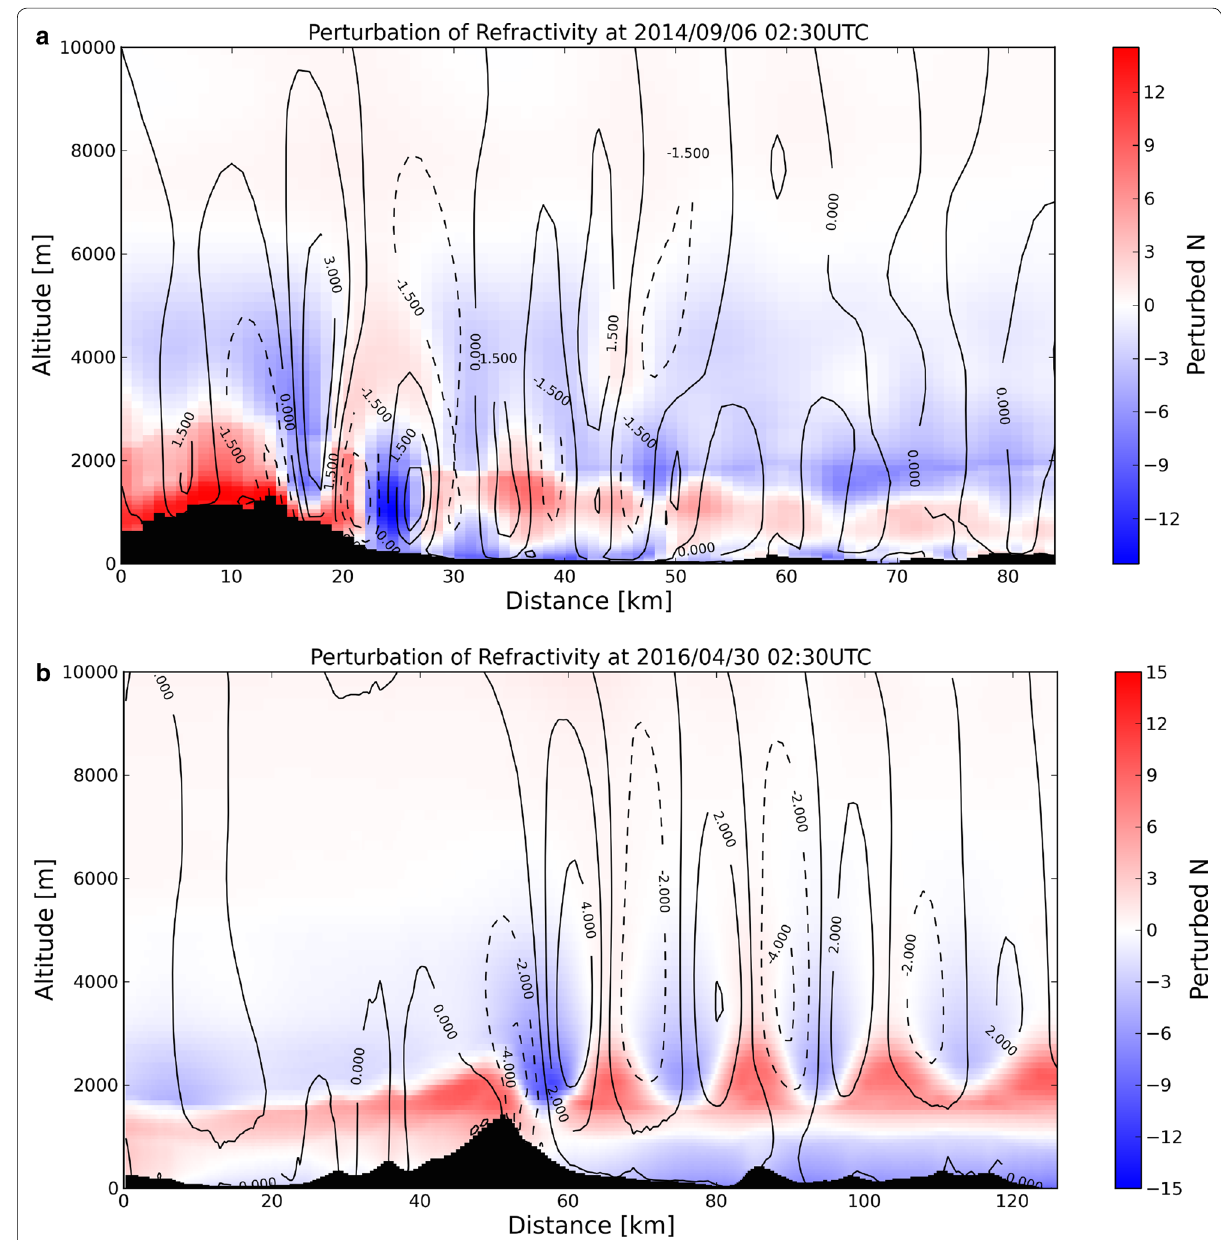
Fig. 6 Vertical profiles of WRF perturbation refractivity. Vertical profiles of perturbation refractivity simulated by WRF along lines shown in Fig. 4. Contour lines represent the vertical wind velocity. a 02:30 UTC on September 6, 2014, and b 02:30 UTC on April 30,